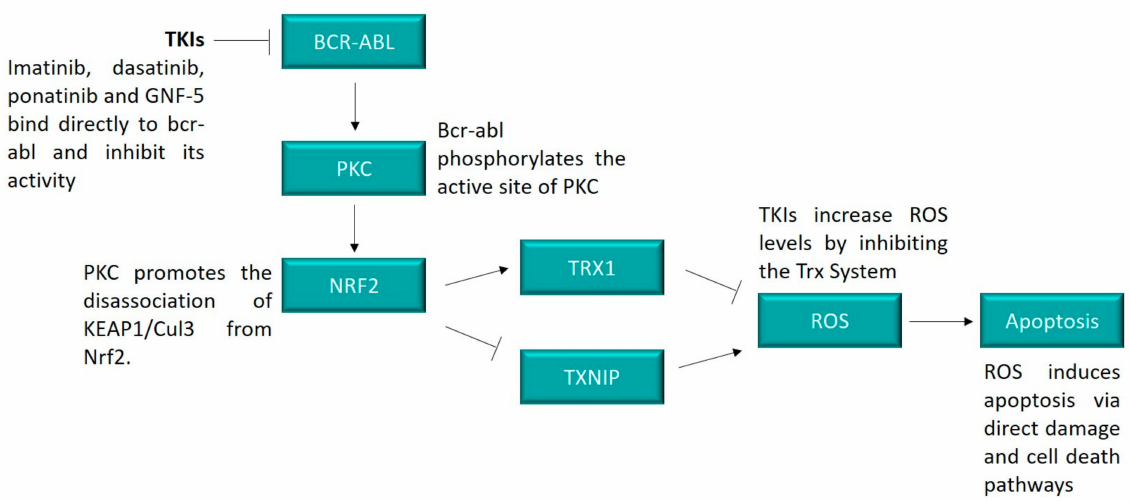
Figure 8. BCR-ABL induces cell death through the TRX system. Inhibition of BCR-ABL by TKIs resulted in a decrease in the expression and activity of the TRX system, likely through the action of PKC. BCR-ABL was shown to activate PKC [44,45], which is a known regulator of NRF2 [12]. The lower activity levels of the TRX system resulted in an increase in ROS, which can lead to apoptosis through a range of mechanisms, including direct damage to DNA, lipids and proteins and the activation of cell death pathways, such as the ASK1